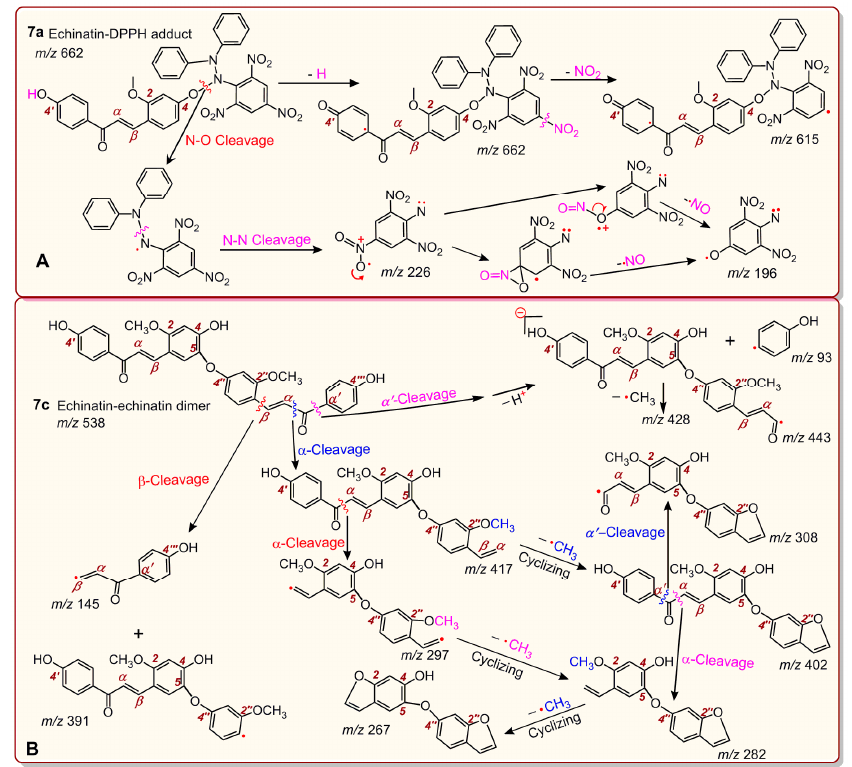
Figure 8. Full MS elucidation of the echinatin–DPPH adduct ( A ) and the echinatin–echinatin dimer ( B ). The MS spectra were obtained in the negative ion mode and the charge imposed by the MS field was not marked. Other reasonable cleavages should not be excluded in the MS elucidation.